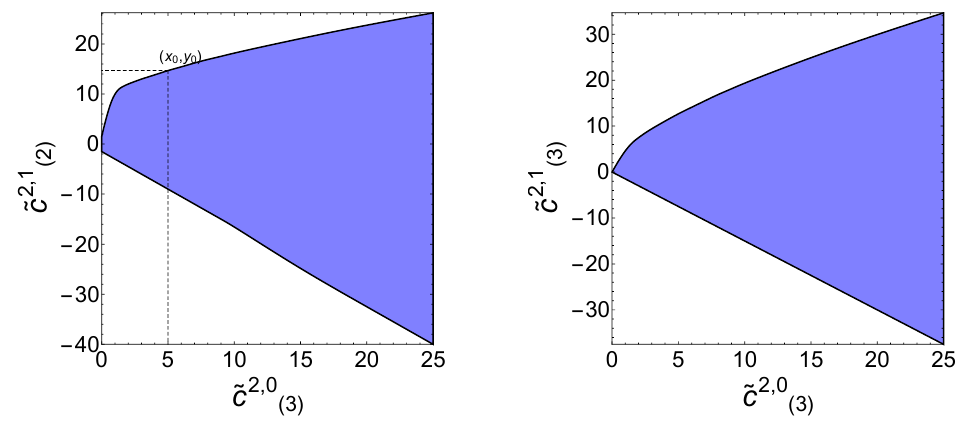
Figure 3 . Positivity bounds on (˜ c 2 , 0 double Z symmetric bi-scalar theory. The SDP includes 3 parameters, c 2 , 0 2 agnostic about all other coefficients. In both the left and right plot, the right hand side of the bound extends to